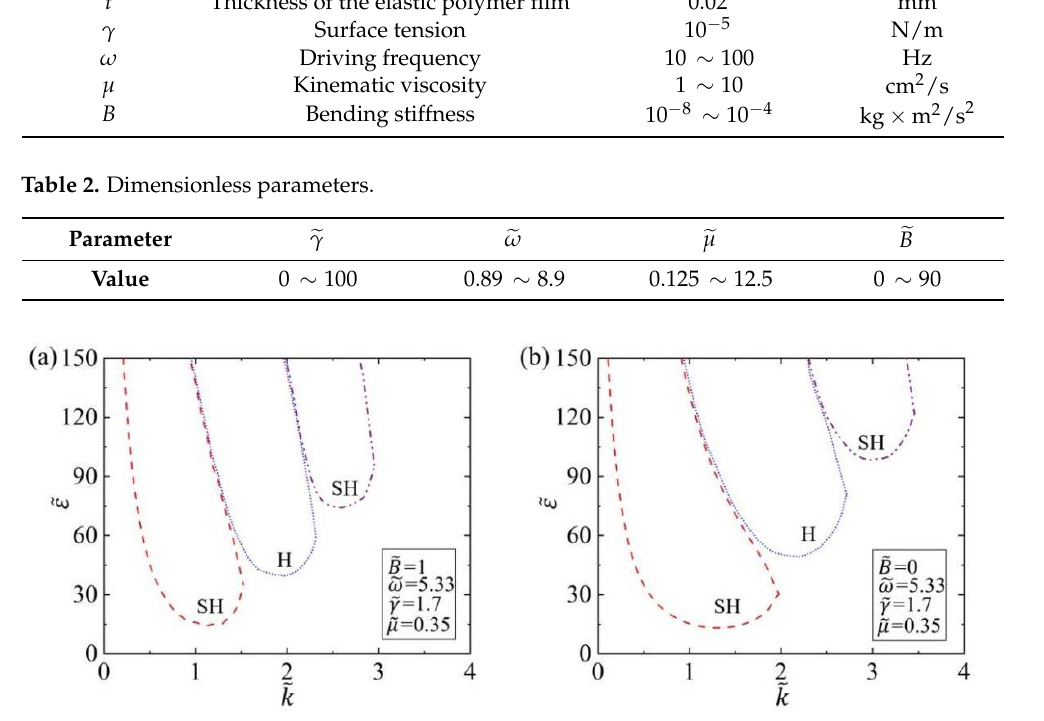
 Figure 2. The marginal stability curves of subharmonic mode and harmonic mode for ( a ) (cid:101) B = 1 and